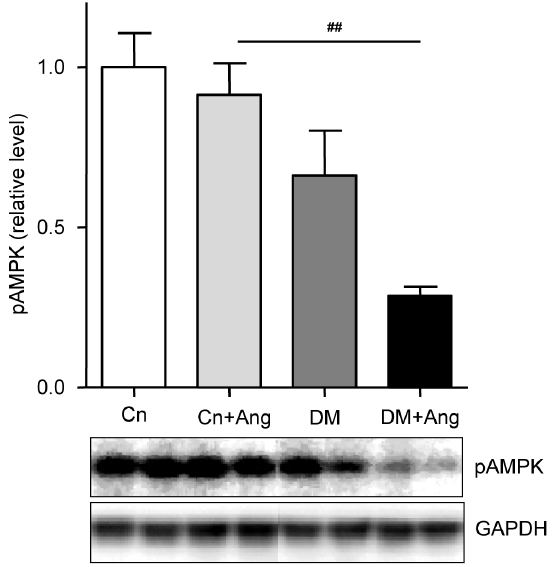
Figure 6. Cardiac phospho-AMPK levels are decreased in hypertensive, diabetic mice. Western blot analysis of LV pAMPK levels in non-diabetic (Cn) and diabetic (DM) mice treated with vehicle or AngII (Ang) for 4 weeks. In the top panel, the quantification of LV pAMPK levels from 4–6 animals per group is shown. Data are analyzed by one-way ANOVA with Bonferroni post-hoc testing and expressed as mean 6 SEM. In the bottom panel, representative examples of pAMPK and GAPDH signals are shown for 2 animals per group. * refers to effect of AngII in non-diabetic and diabetic mice (* P , 0.05, ** P , 0.01, *** P , 0.001) and # refers to effect of diabetes in vehicle-treated and AngII- treated mice ( # P , 0.05, ## P , 0.01, ### P , 0.001).